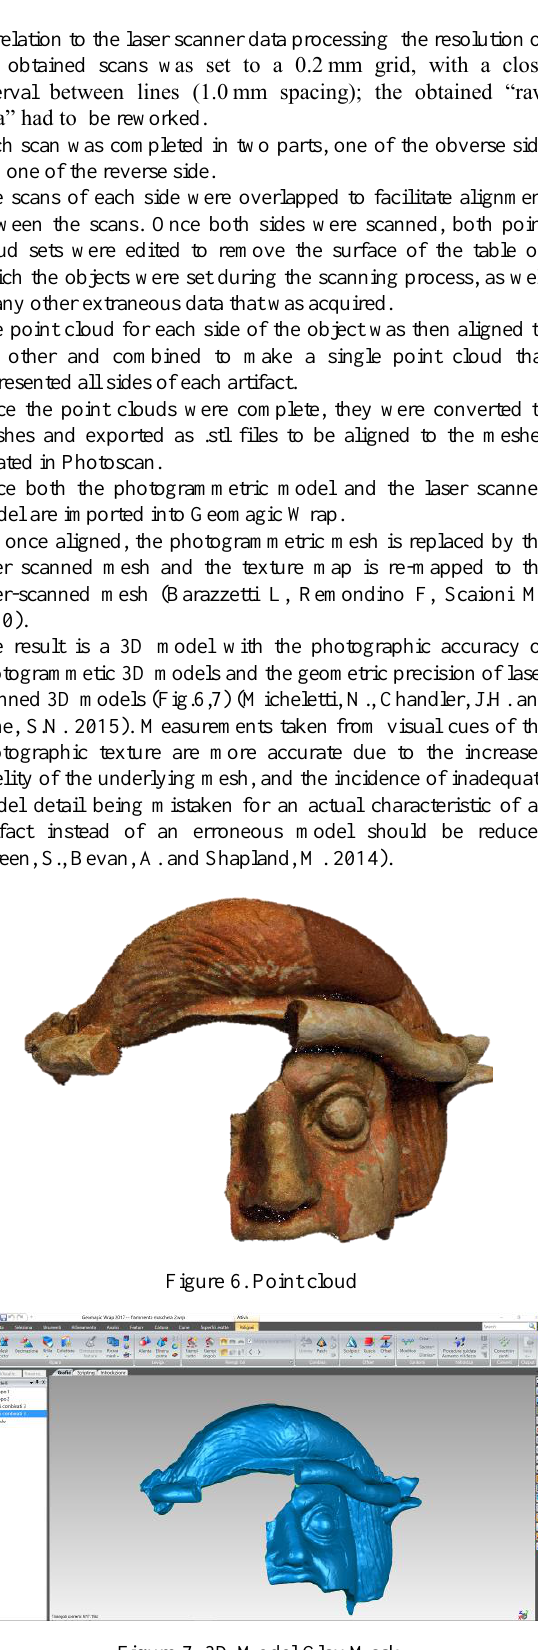
Figure 5. 3D Model Kouros